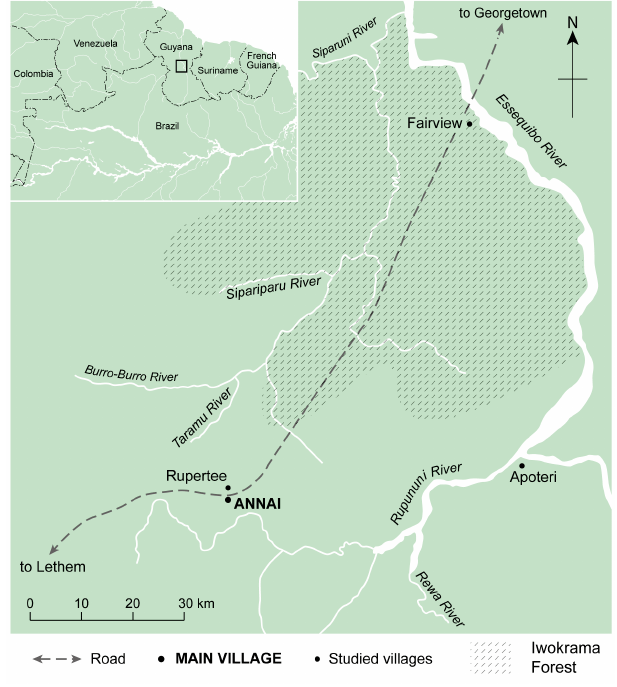
Fig. 1 . Map showing the studied villages in the North Rupununi, Guyana, within the context of the Guiana Shield